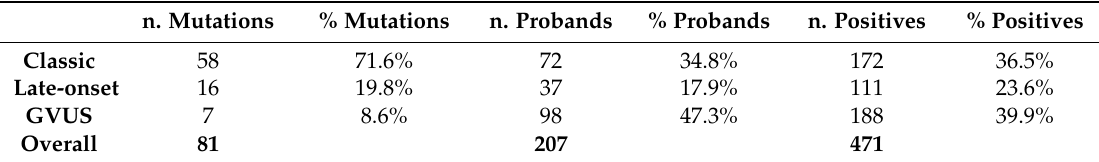
Table 4. Phenotype associated with 81 mutations detected in individuals with a mutation in the GLA gene, phenotype of 207 Probands, and 471 positives (Probands + relatives)in genetic test. n. Mutations % Mutations n. Probands % Probands n. Positives % Positives